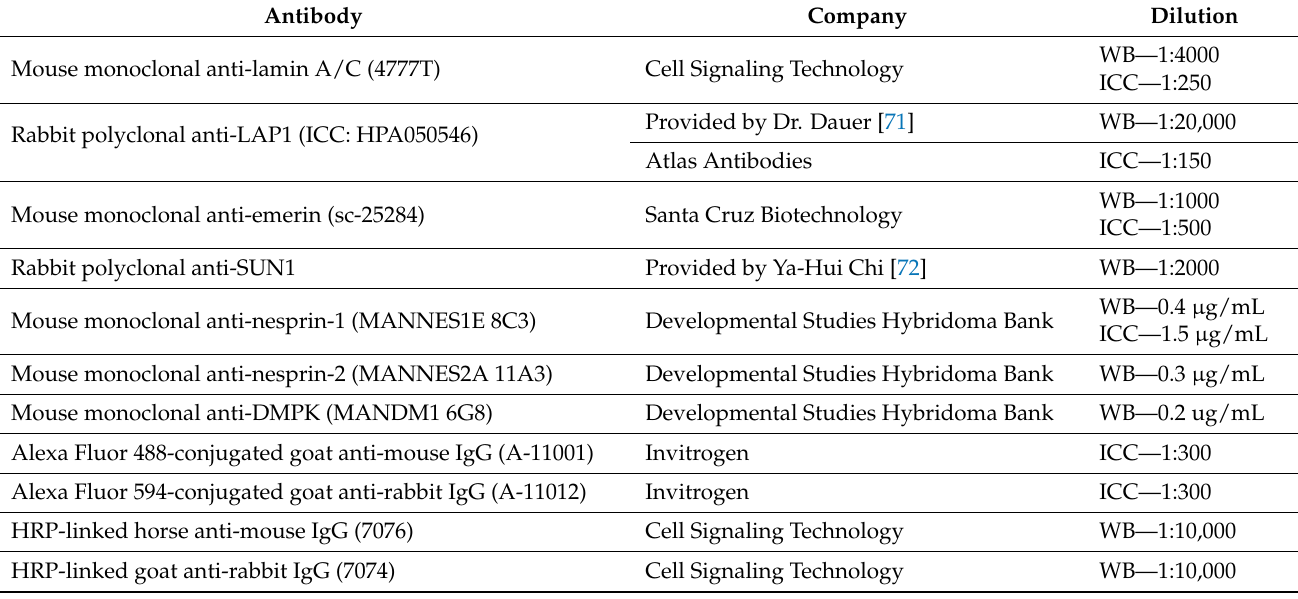
Table 1. Primary antibodies used to detect the multiple proteins analyzed by Western blotting and